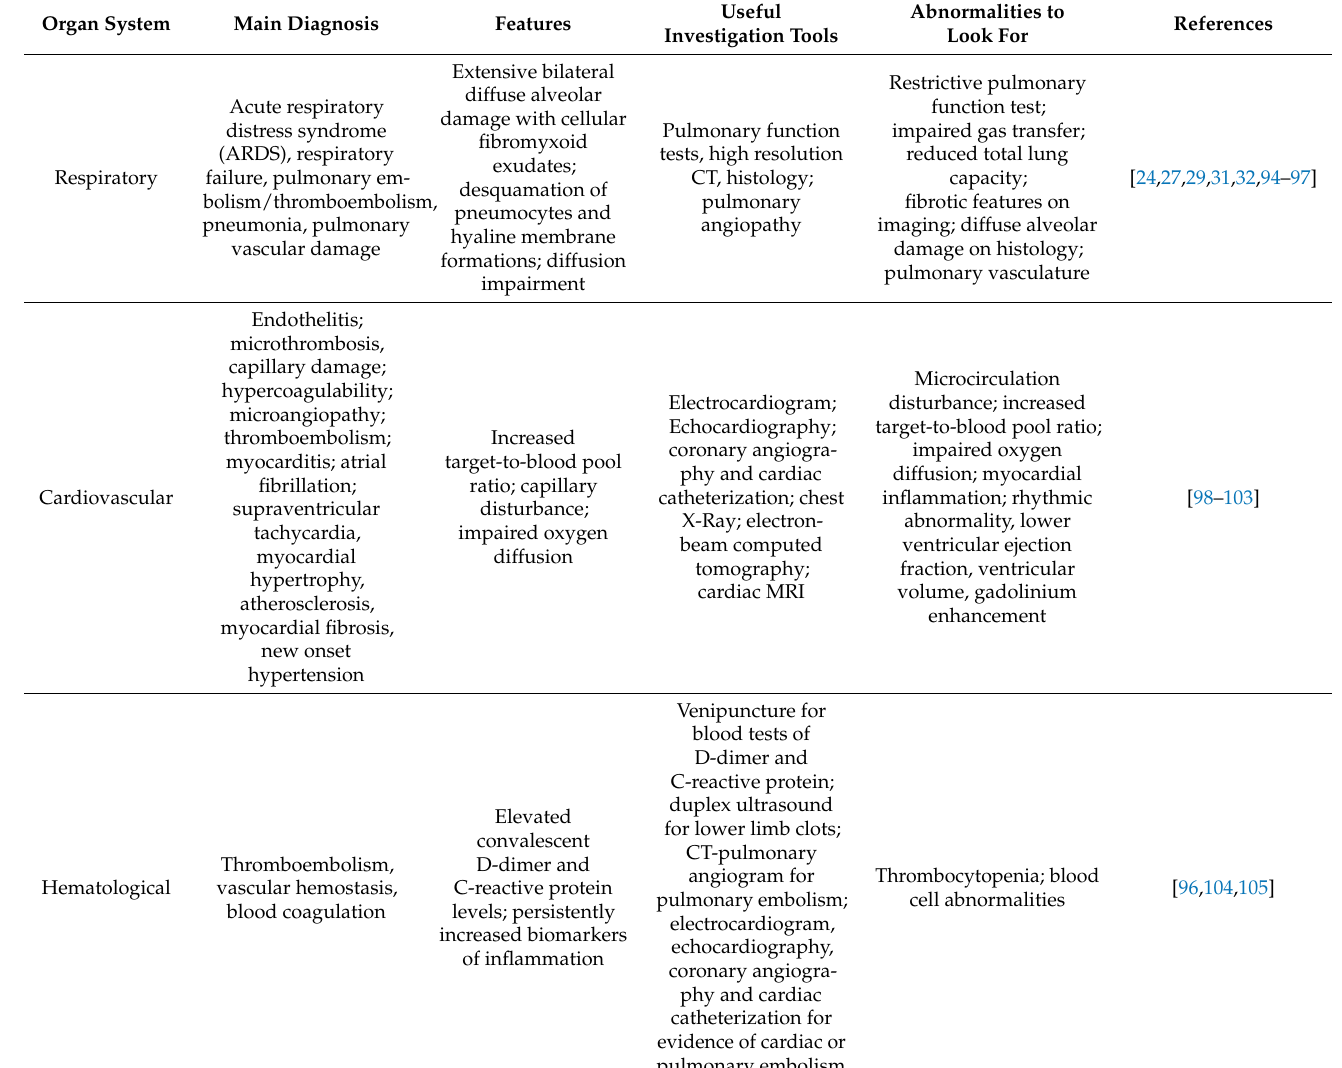
Table 2. Useful investigation tools for patients with Post-COVID-19 Syndrome